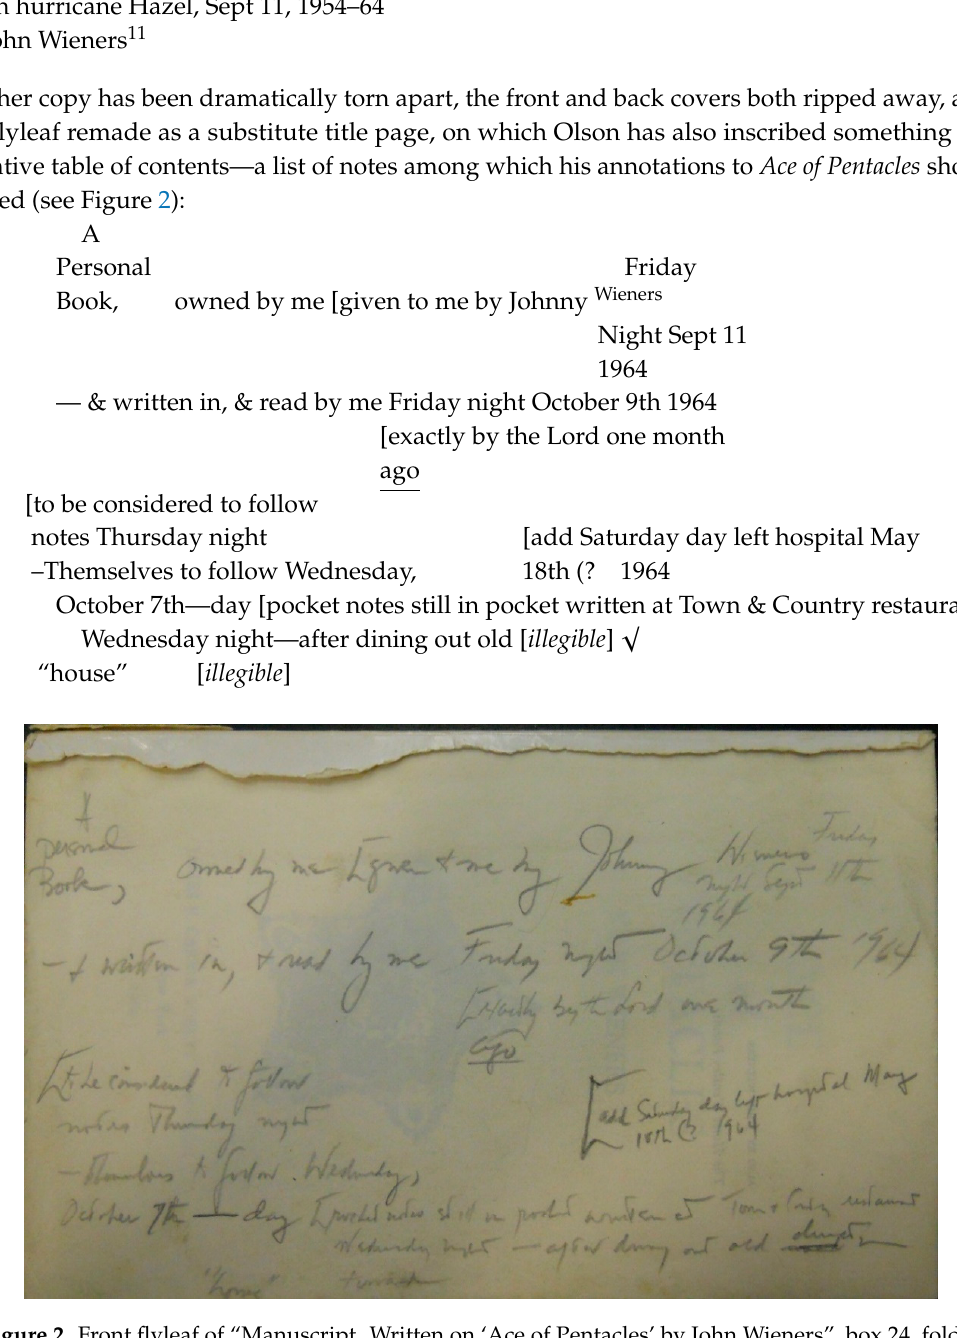
Figure 2. Front flyleaf of “Manuscript. Written on ‘Ace of Pentacles’ by John Wieners”, box 24, folder 1147,